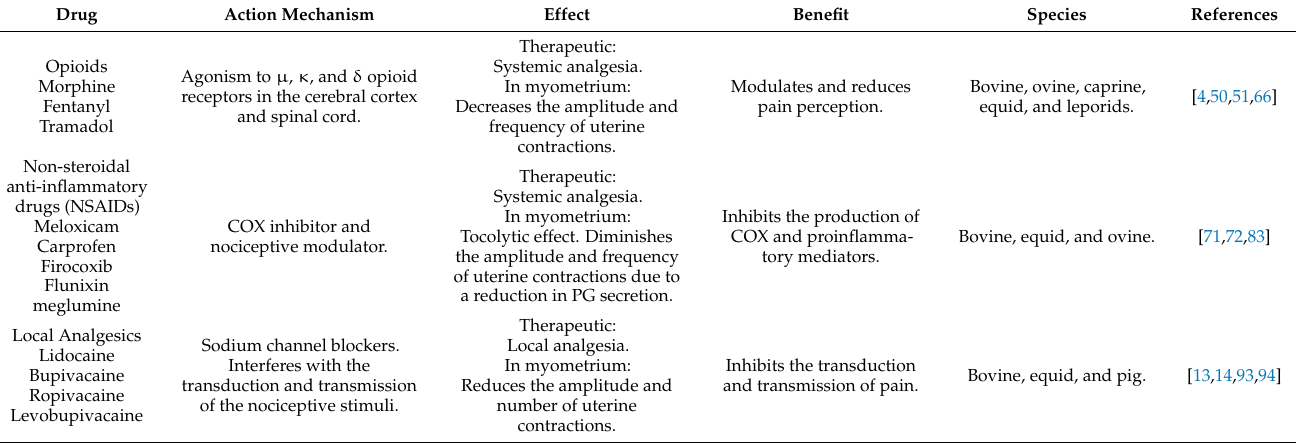
Table 1. Summary of the different analgesic drugs used during parturition in domestic